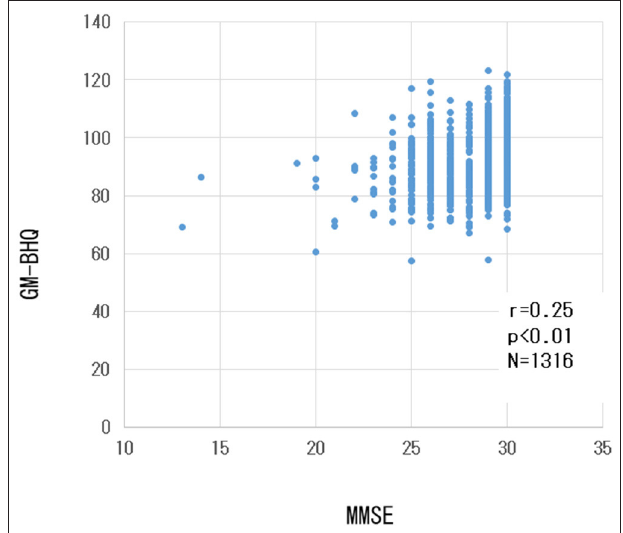
FIGURE 4 | Scatter plot of GM-BHQ and MMSE scores. The vertical axis indicates the GM-BHQ, and the horizontal axis indicates MMSE scores.